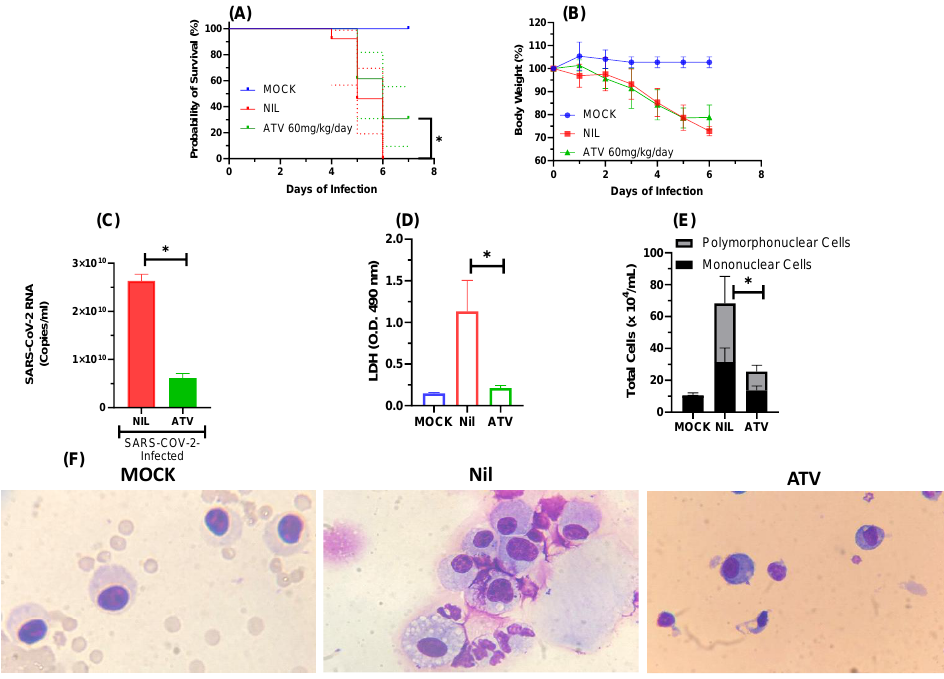
Figure 3. Pharmacokinetics of atazanavir (ATV) in mice. Swiss–Webster mice at 8–15 weeks of age were orally treated with 60 mg/kg of ATV. ( A ) At indicated time points, concentration of ATV was measured in the plasma and in the lungs. The insert in panel A represents the pharmacokinetic parameters in the plasma. ( B ) The area under the curve (AUC) for the anatomical compartments were registered.